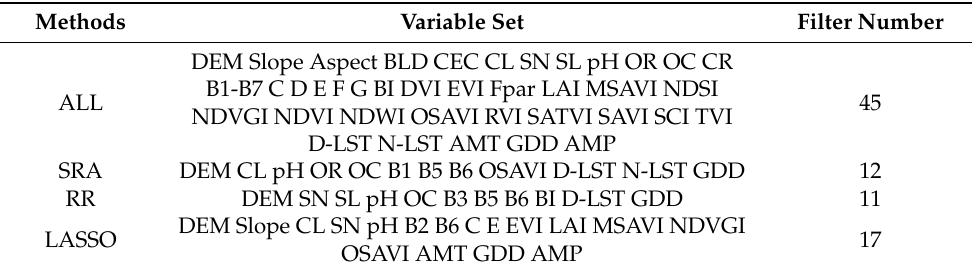
Table 2. Results of variables screening by different screening methods.